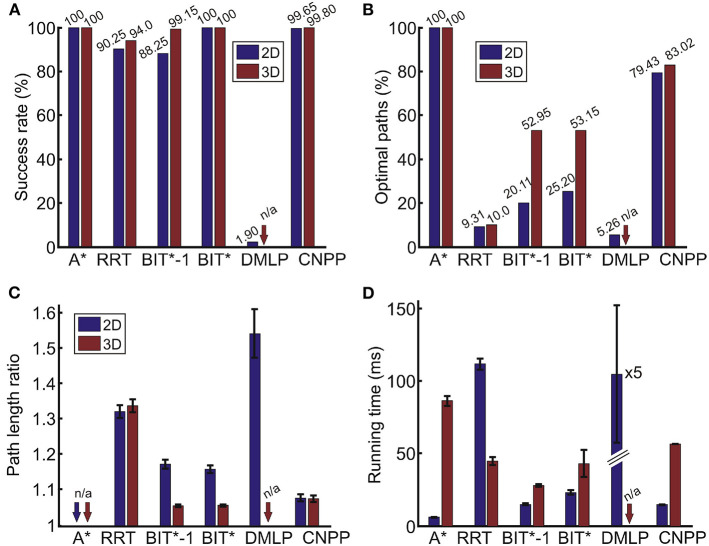
Comparison of different approaches obtained from 2,000 unseen 2D and 3D environments. (A) Success rate SR, (B) percentage of optimal paths OP, (C) average path length ration of non-optimal paths LR (not applicable for the A* since all paths are optimal), and (D) average run-time. Error bars denote confidence intervals of the mean (95%). A*, A-star algorithm (Hart et al., 1968); RRT, rapidly-exploring random tree algorithm (LaValle, 1998); BIT*-1, batch informed trees with a single batch (Gammell et al., 2020); BIT*, batch informed trees with multiple batches (Gammell et al., 2020); DMLP, deep multi-Layer perceptron (Qureshi et al., 2019); and CNPP, convolutional network for path planning (our method).